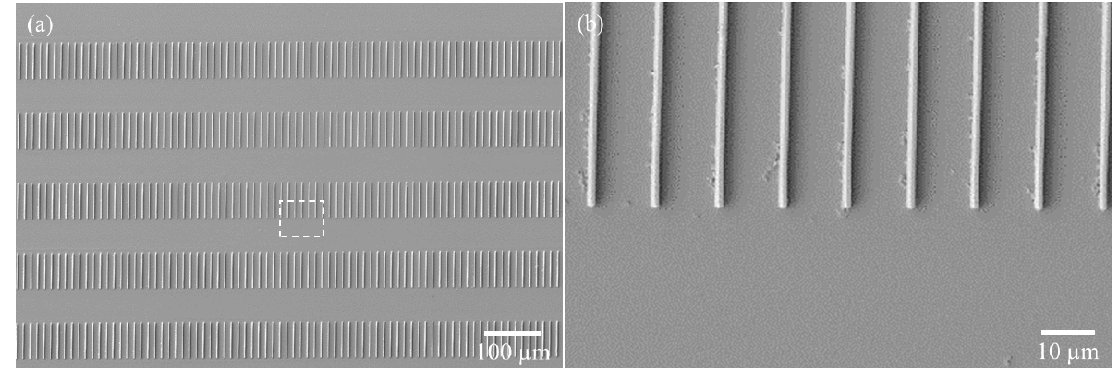
Figure 8. ( a ) 1-to-1 line length and space exposed by the micron scale mask and ( b ) the shape of each line in the oblique fusion structures.